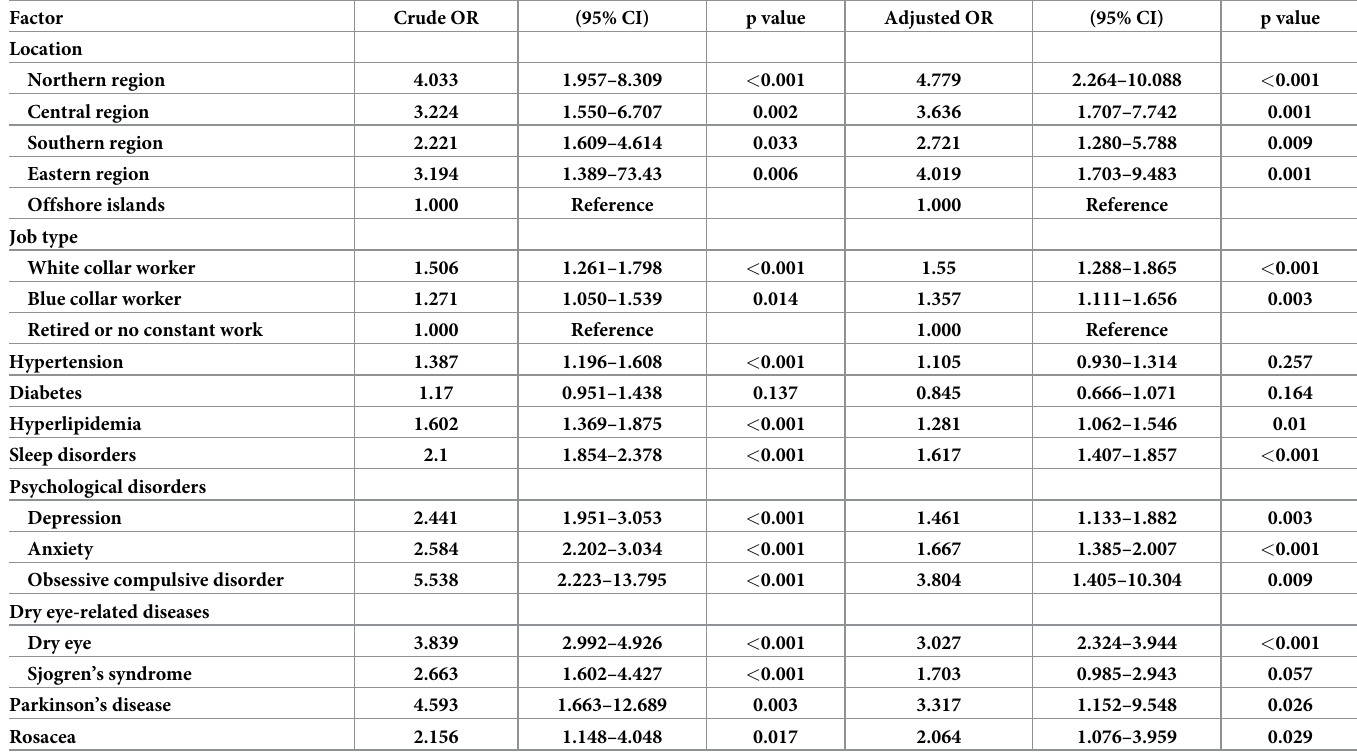
Table 2. Crude and adjusted odds ratios for benign essential